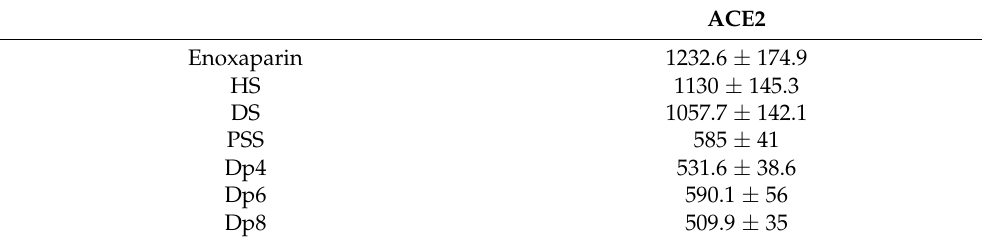
Table 2. Kd values (nM) for ACE2 to HS, DS, Enoxaparin, PPS and size-defined LMWH fractions.